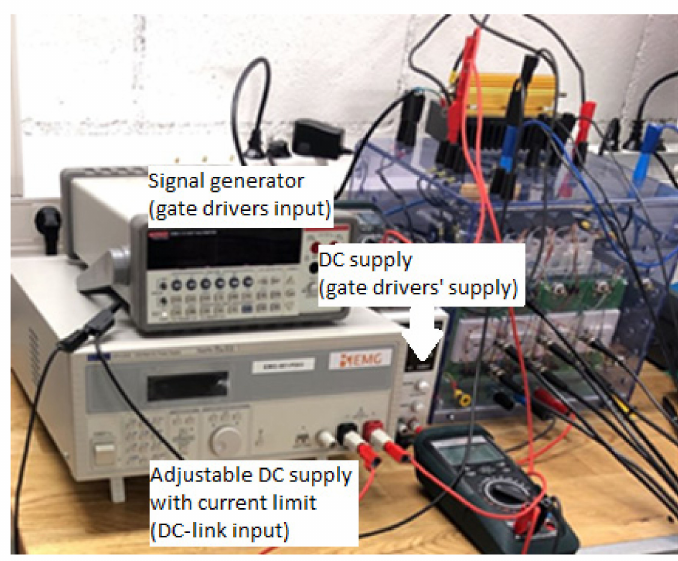
Figure 8. The inverters gate drivers test.